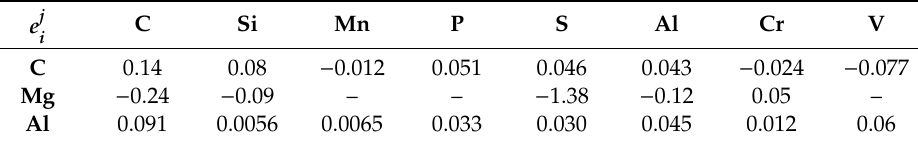
Table 6. Interaction coe ffi cients for bulk steel at 1873 K